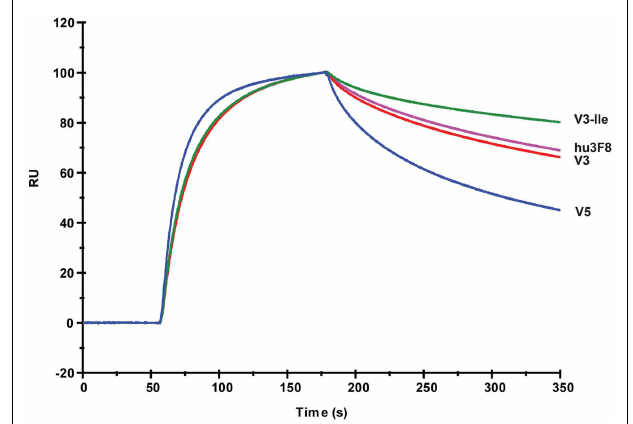
FIGURE 2 | Composite surface plasmon resonance sensorgram of the binding hu3F8,V3,V3-Ile, andV5 to ganglioside GD2 . Analysis of binding kinetics is shown in Table 5 . Full sensorgrams are presented in Figure S1 in Supplementary Material.